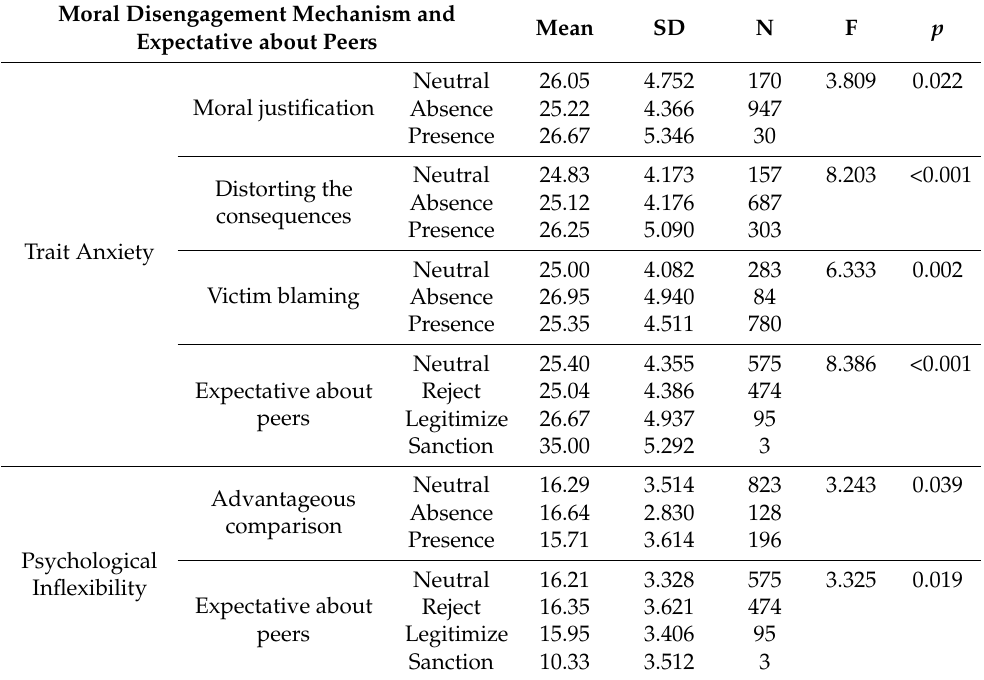
Table 4. Differences in moral disengagement mechanisms and expectations of peers by trait anxiety and psychological